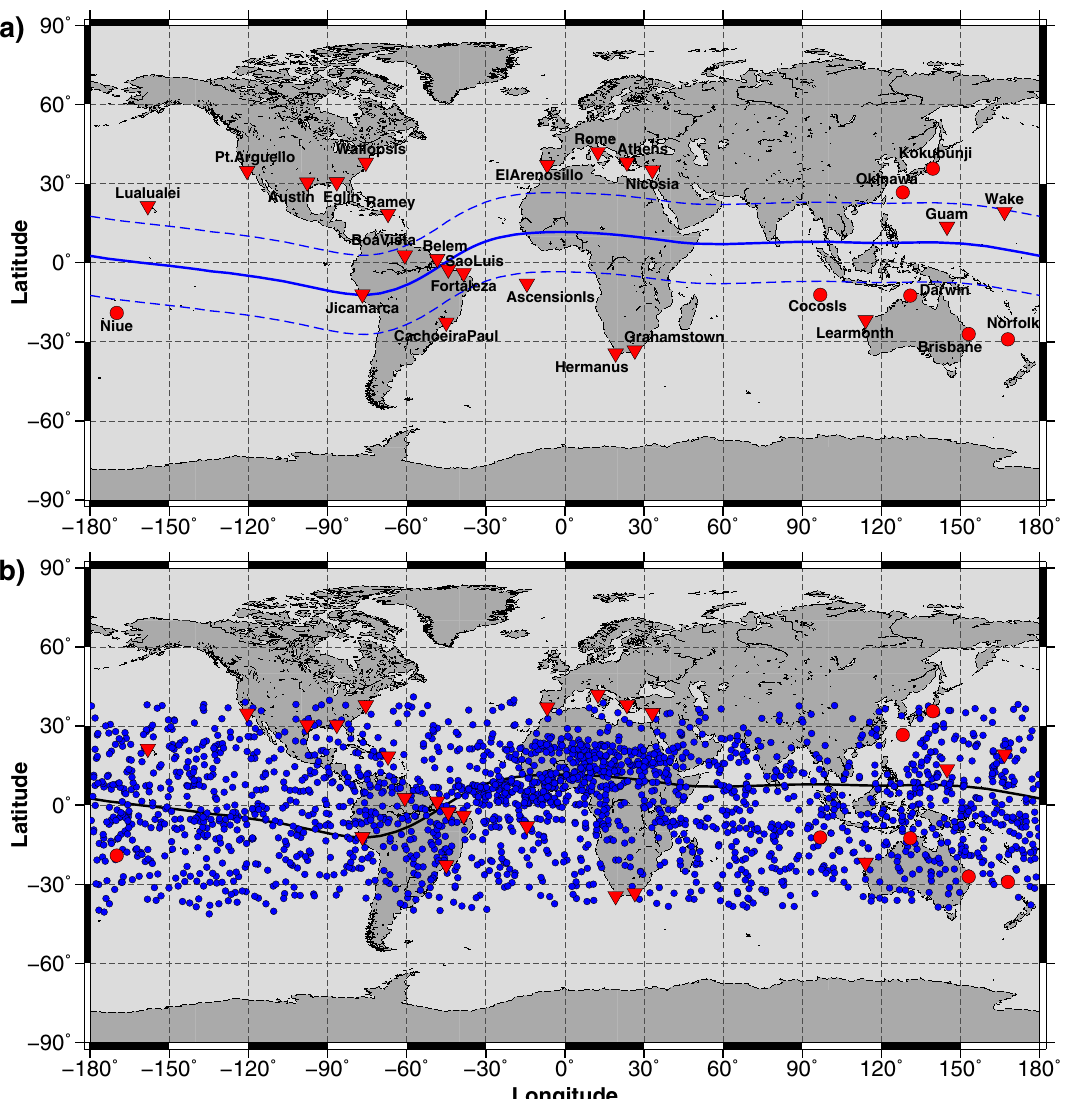
Fig. 1. (a) Geographical map with Digisondes (red triangle) and ionosondes (red circles) locations used in this study; lines show the magnetic equator and ±15 (cid:1) MLAT. (b) Example of global distribution of the F2 peak points as derived from COSMIC-2 RO observations during 24